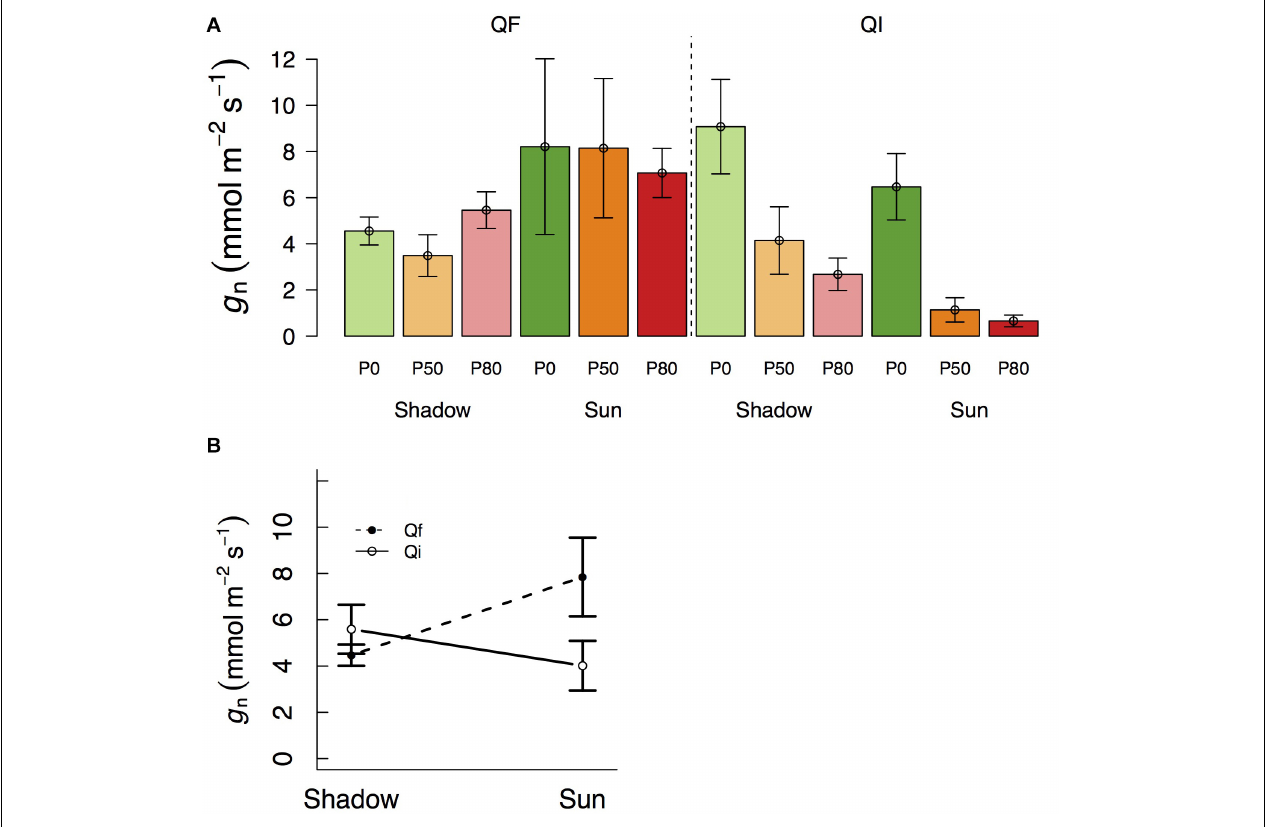
FIGURE 2 | (A) Variation in residual conductance measured from nocturnal conductance under high D (g n ) across different light treatments (shadow vs sun) and water treatments (P 0 , P 50 , and P 80 ). Significant interactions across treatments are plotted in (B) . Bars indicate mean values per treatment and error bars indicate